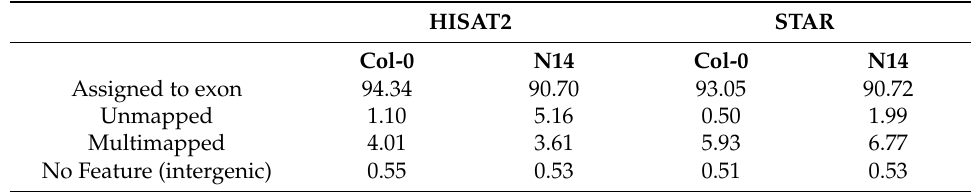
Table 4. Fraction of reads mapped to known exons for HISAT2 and STAR. HISAT2